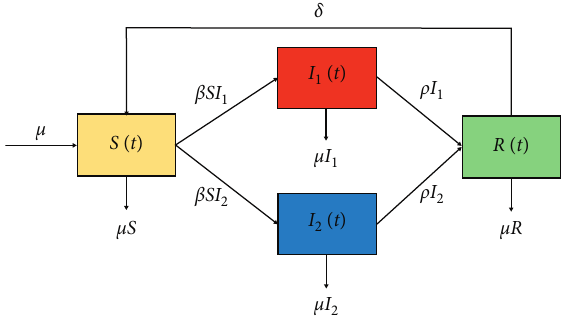
Figure 1: The compartmental diagram for the SIRS model with two epidemic